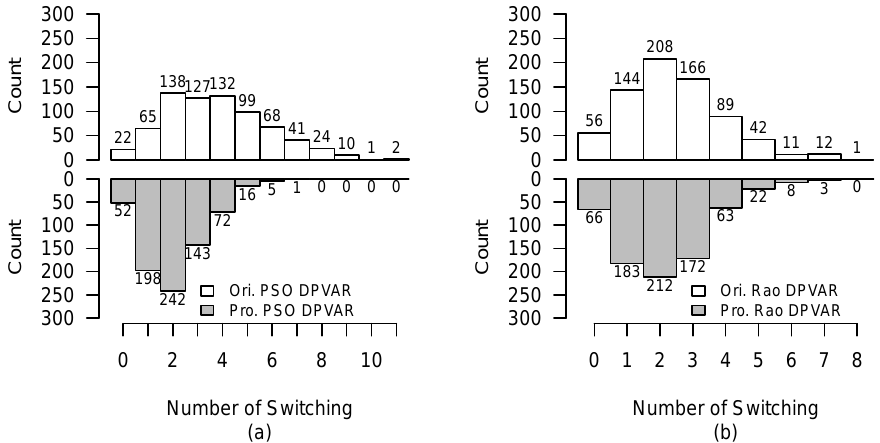
Figure 27. Comparison of switching operation of original-reconfigured and proposed-reconfigured PV arrays under Case 1 with lagged time. ( a ) PSO-reconfigured PV array. ( b ) Rao-reconfigured PV array.